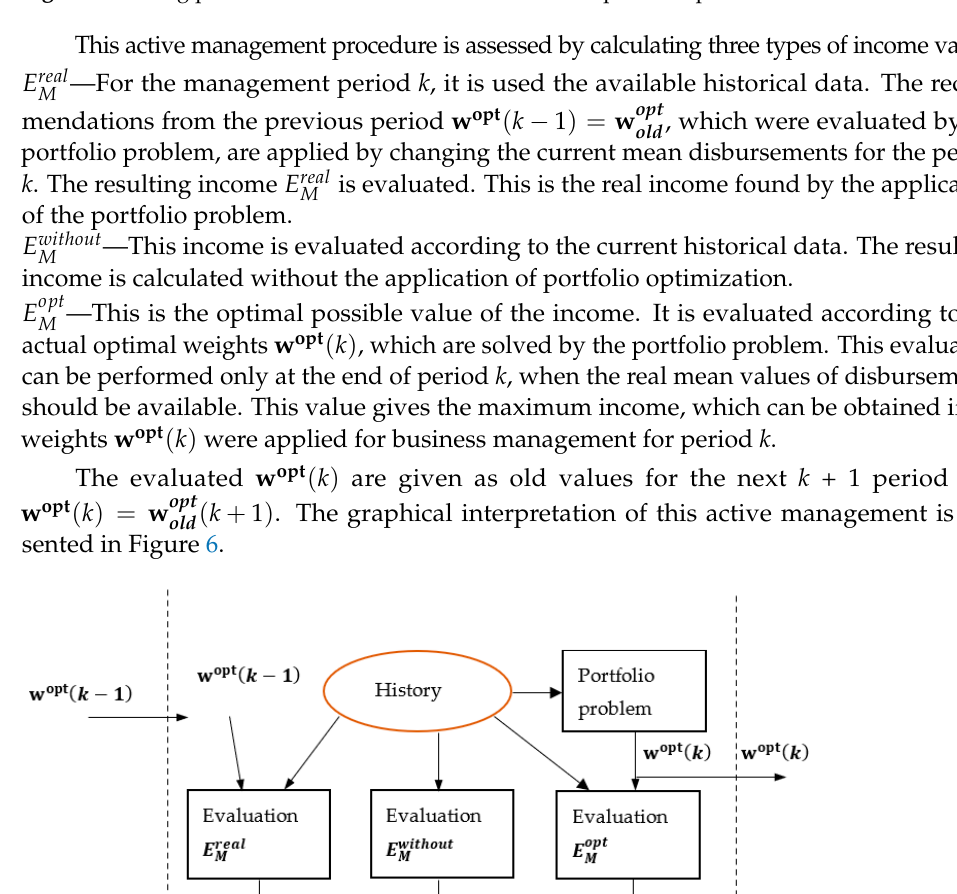
Figure 5. Rolling procedure for definition and solutions of portfolio problems.